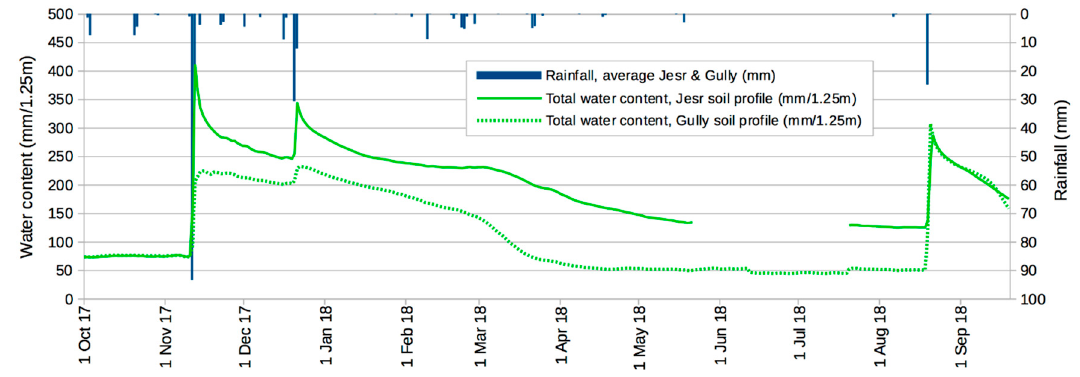
Figure 5. Total water content in the Jesr and gully soil profiles and daily rainfall (values are averages of the Jesr and gully).